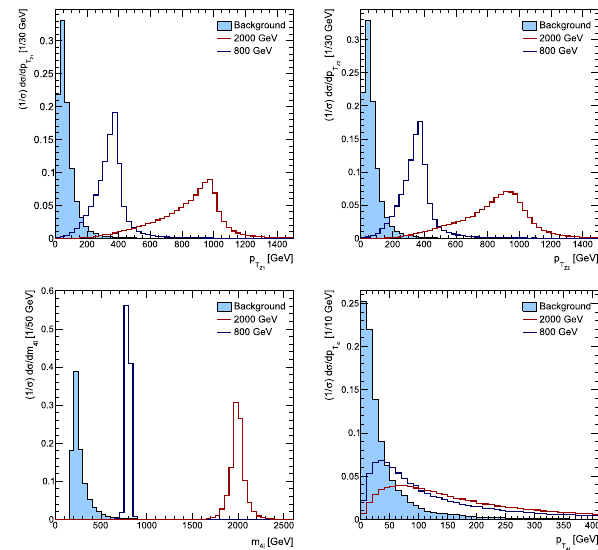
Fig. 8 Normalized differential cross sections as a function of leading lepton p T ( a ), second-leading lepton p T ( b ), third-leading lepton p T ( c ) and fourth-leading lepton p T ( d ) for m h 800 GeV (blue line) and background (blue solid) at